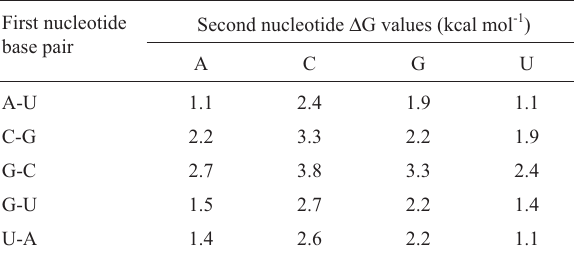
Table 1 - Standard Gibbs energy of activation Δ G values (kcal mol -1 ) used for calculating the internal stability of RNA duplexes. The equation used was Δ G = S Gas - S Gs , where S Gas = Sum of the Δ G values for the first four nucleotides in the anti-sense 5’ region, S Gs = Sum of the Δ G values for the first four nucleotides in the sense 5’ region. Note that Δ G ≤ for the non-functionalstrandand Δ G>0forthefunctionalstrand.Tablemodified from Khvorova et al. , 2003).